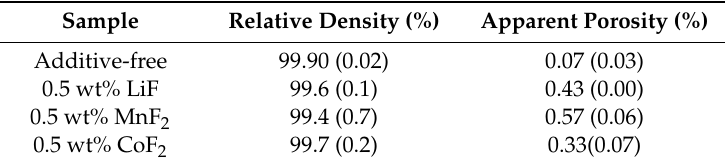
Table 1. Relative density and apparent porosity of additive-free and transition metal fluoride-doped samples produced by spark plasma sintering (SPS) at 1400 °C (no isothermal dwell). The numbers in parenthesis represent standard errors.